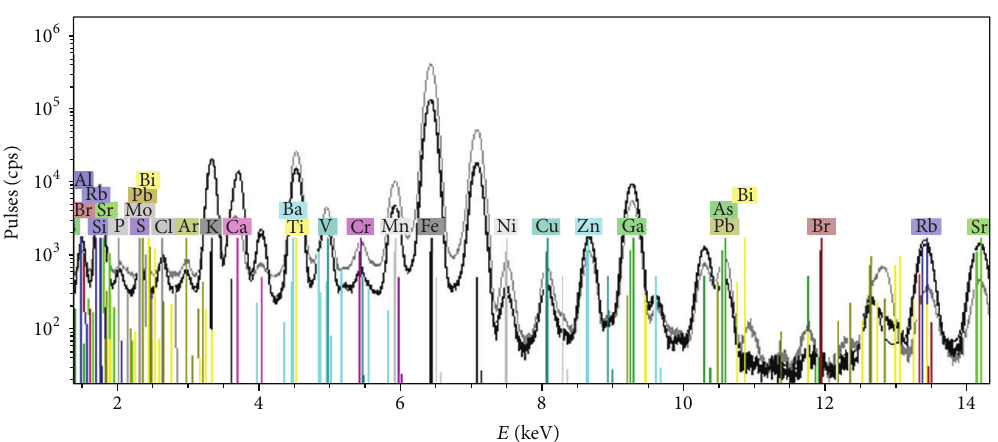
Figure 1: TXRF spectra of soil samples from Korba (black) and Raipur